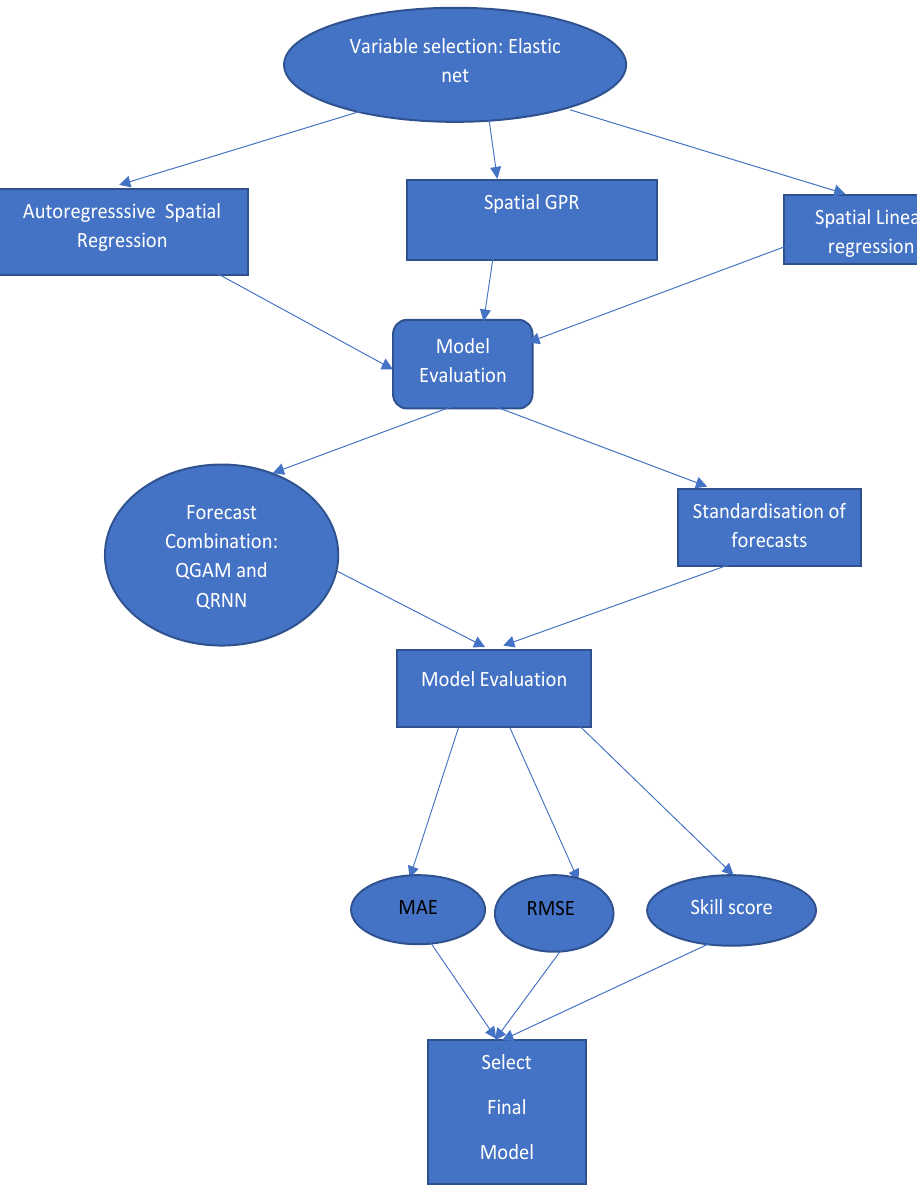
Figure 1. Flow chart of the structure of the